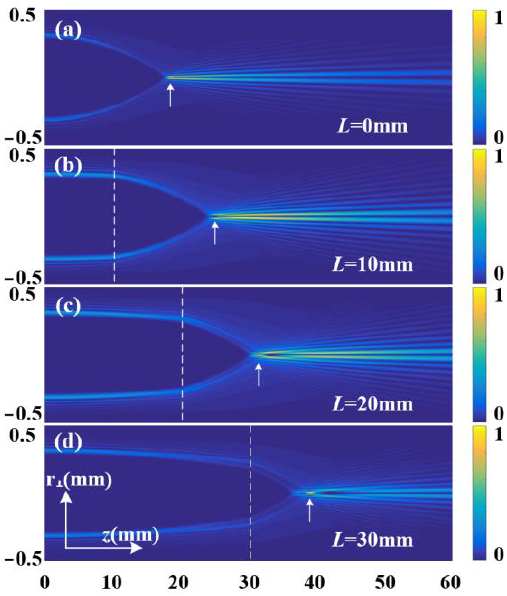
Figure 2. Normalized intensity distributions during propagation under different crystal lengths. ( a – d ) Results for L = 0 mm, 10 mm, 20 mm and 30 mm, respectively. The white dotted lines are the output planes of the crystals, and the white arrows show the location of the focus .